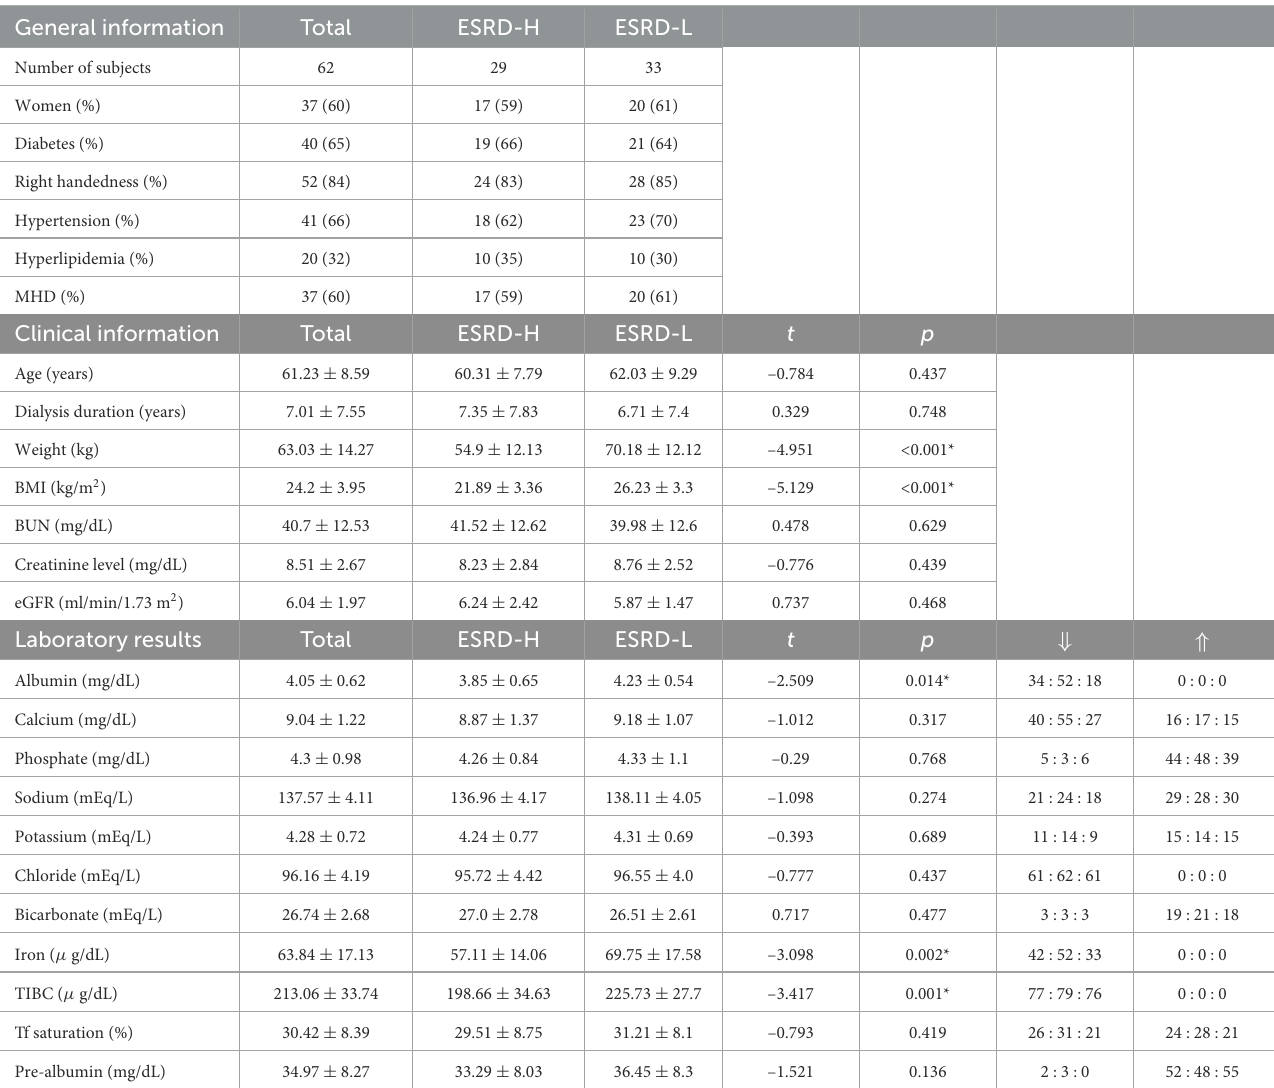
TABLE 1 Demographic characteristics of ESRD patients.